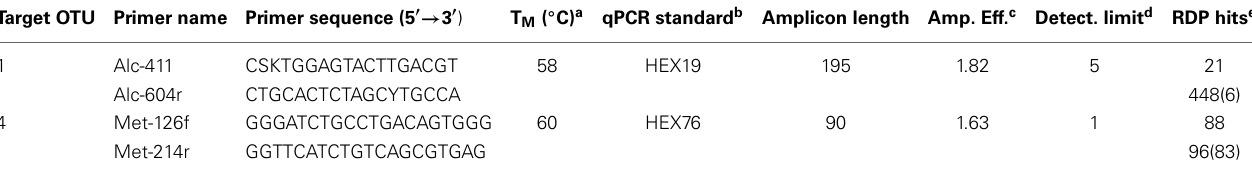
Table 1 | Quantitative PCR primers developed and used in this study.